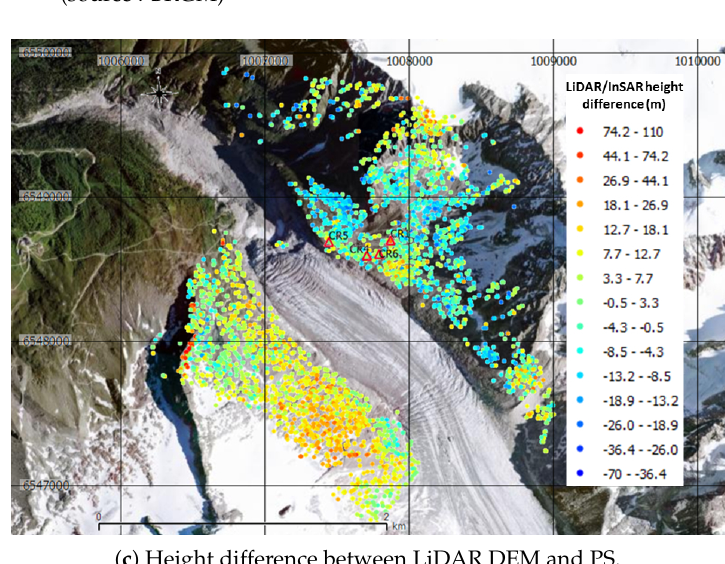
Figure 14. Deformation rates, geologic and height difference maps. The line of sight direction in indicated by a red arrow. The colorbar used for deformation rates is tilted so that the angle with the vertical corresponds to the incidence angle of 45 ◦